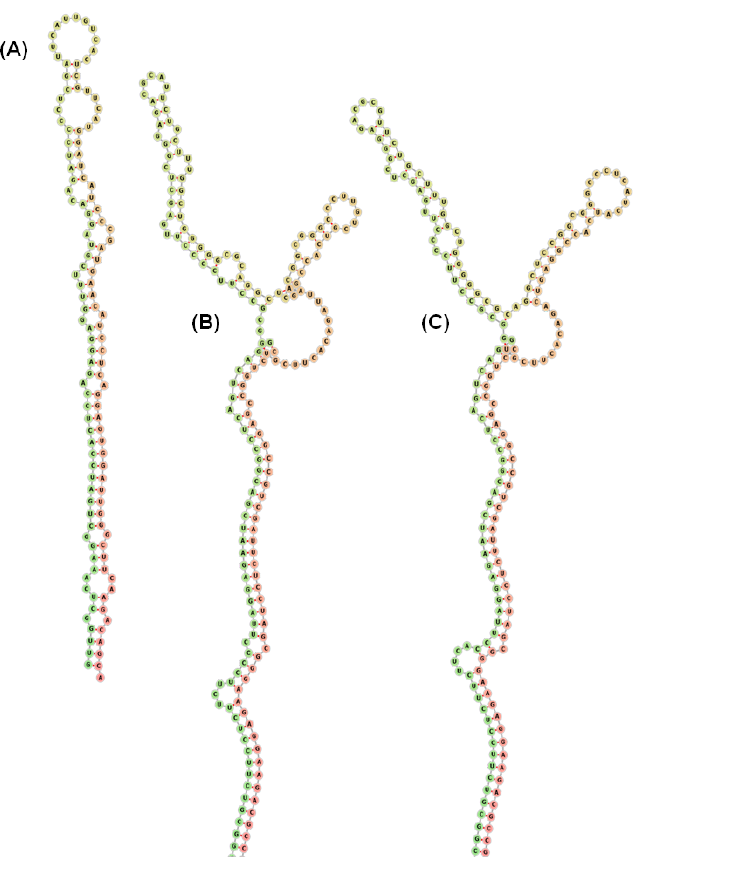
Figure 5. The RNAfold web server predicted the folding structure of the precursor osa-miR5510 ( A ), osa-miR3980a-3p ( B ), and osa-miR3980b-3p ( C ).